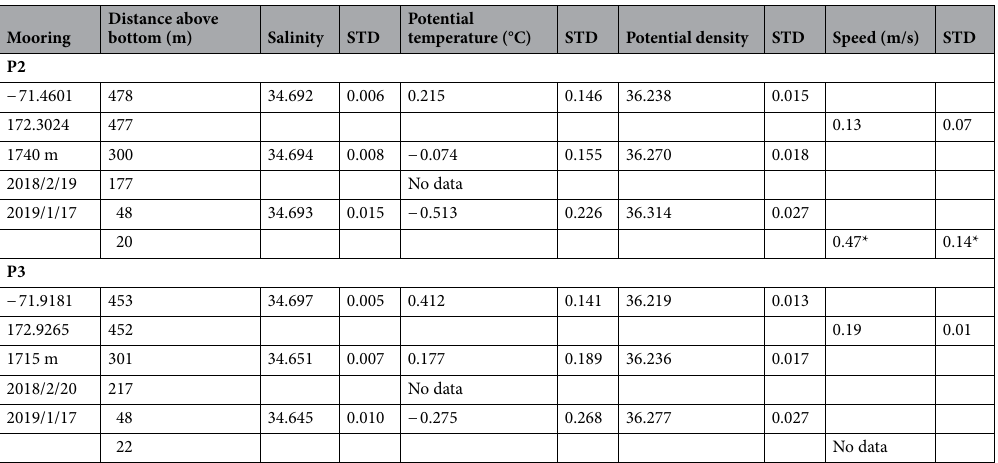
Table 1. Instrumentation, depth, location and deployment dates for the P2 and P3 moorings. The mean and standard deviation of properties from each sensor are given. Three instruments did not return data and the lowest current meter on the P2 mooring collected data for only 1 month (denoted by an